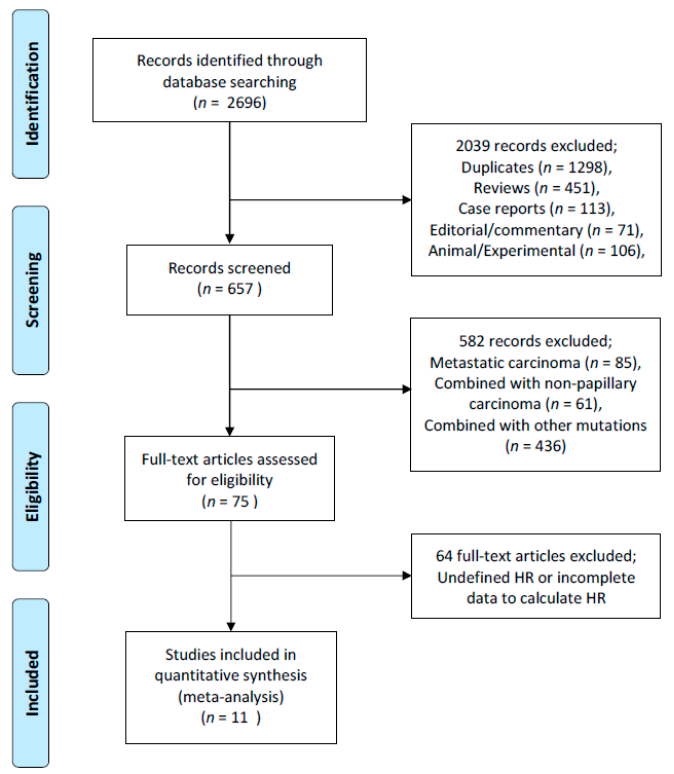
Figure 1. The preferred reporting items for systematic reviews and meta-analyses (PRISMA) flow diagram of the including studies.